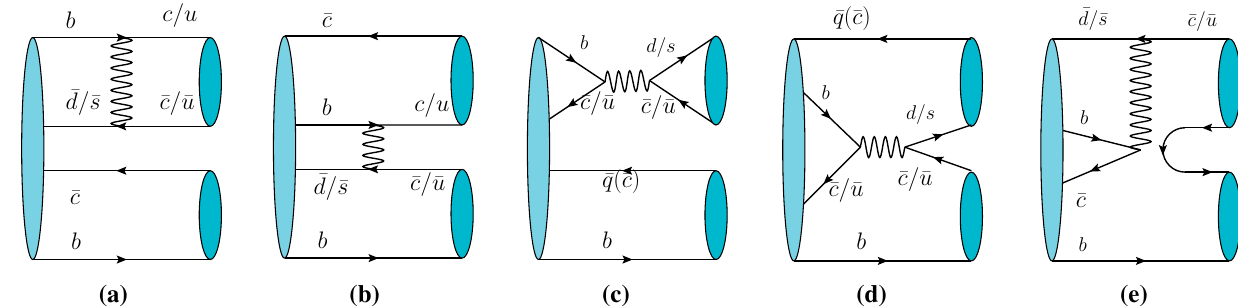
{ bb } Fig. 3 The Feynman diagrams for the tetraquark T {¯ c ¯ q } non-leptonic decays into mesons { bb } Table 3 Tetraquark T Channel Amplitude Channel {¯ c ¯ q } decays into two mesons with the transition of b → c ¯ cd / s